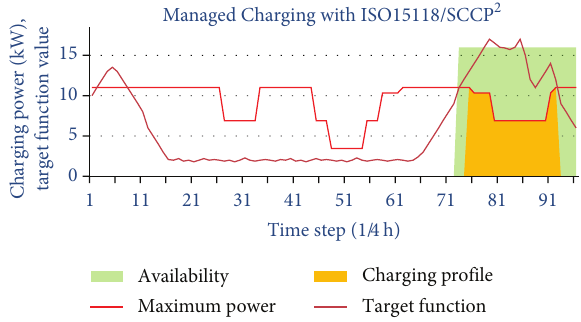
Figure 1: Managed Charging using target and restriction